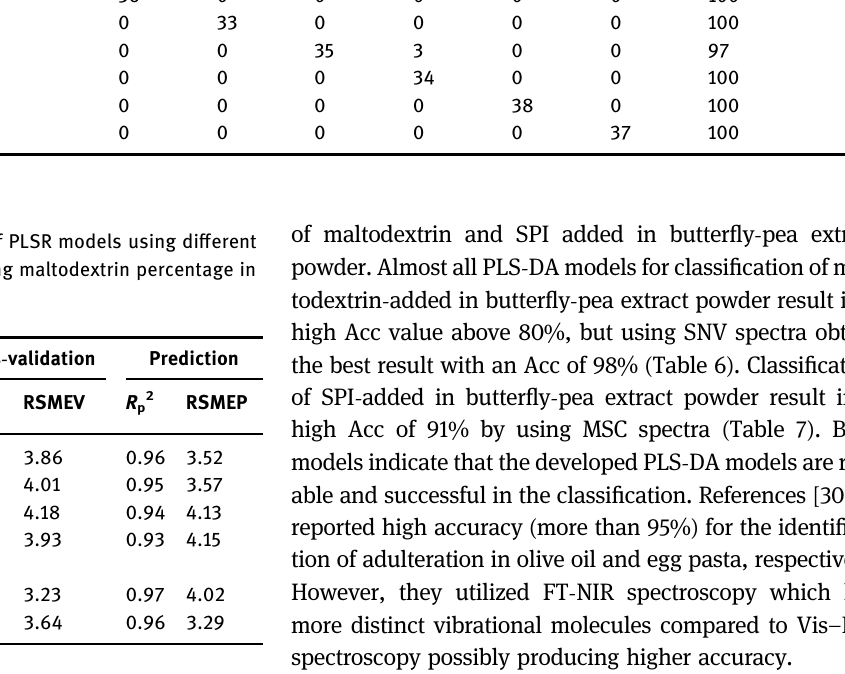
Table 5: Calibration and validation of PLSR models using di ff erent pre - processing methods for predicting SPI percentage in butter fl y - pea extract powder